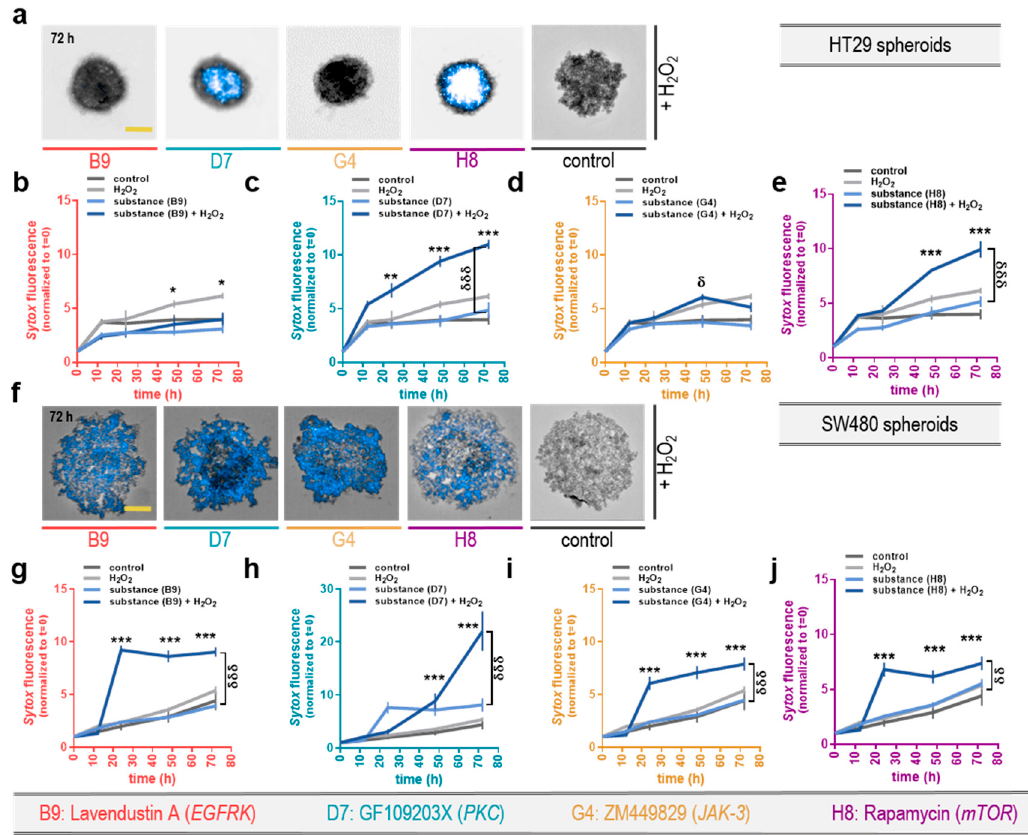
Figure 5. Validation of the toxicity of selected kinase inhibitors with H 2 O 2 in 3D tumor cell spheroids of HT29 and SW480 colorectal cancer cells. ( a ) Representative maximum projection intensity from 16 z-stack images of spheroids formed from HT29 colorectal cancer cells (scale bar = 500 µm) and the quantification of the Sytox mean fluorescence intensity +SEM inside the spheroids shaped from initially 3 × 10 3 cells during a 72 h time-course ; ( b ) representative images of spheroids from HT29 colorectal cancer cells during a 72 h time course exposed to the substances B9, ( c ) D7, ( d ) G4, and ( e ) H8 (+/- H 2 O 2 ); ( f ) representative maximum projection intensity images from 16 z-stacks of SW480 colorectal cancer cell spheroids (scale bar = 500 µm); ( g ) the quantification of the Sytox mean fluorescence intensity +SEM inside the spheroids after exposure to the substances B9, ( h ) D7, ( i ) G4, and ( j ) H8 (+/- H 2 O 2 ) Significance levels for the comparison of substances without H 2 O 2 to the respective substances with H 2 O 2 ( δ ), and of their combination (with H 2 O 2 ) to the H 2 O 2 -alone control (*) were determined via ANOVA. Data are representatives out of five (a–e) or three (f–j) independent replicates.